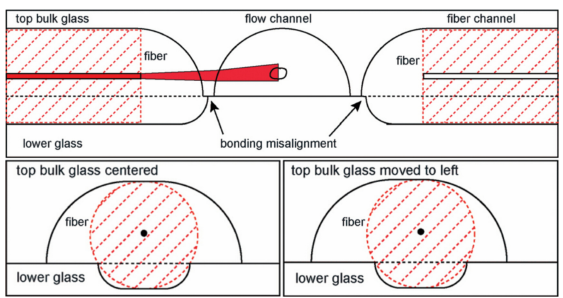
Figure 3. The chip geometry of the double glass layer assembled optical stretcher. The two glass layer are etched asymmetrically, the top one for large part of the fiber and the entire fluidic channel, the bottom one with shallow grooves for fiber alignment. The misalignment between these two layers show the robustness of this new etching layout. Figure reproduced from Reference [25] under CC-BY 3.0